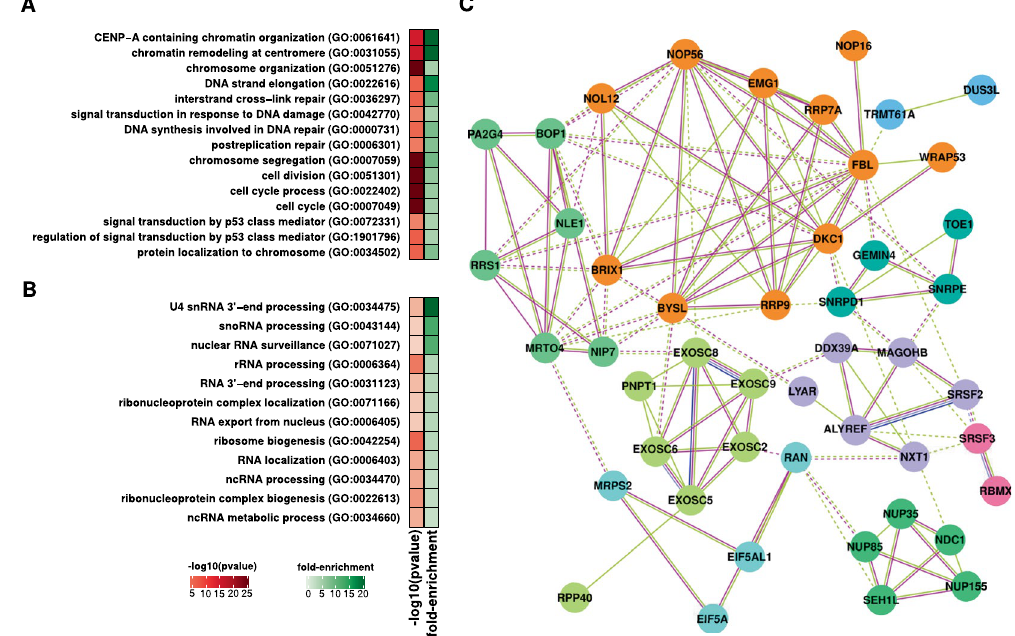
Figure 1. Characteristics of downregulated genes at 24 hours (T24) after radiation exposure in glioblastoma cell lines. ( A ) Enriched gene ontology related to cell cycle, DNA replication, and repair among downregulated genes. ( B ) RNA-related Gene Ontology (GO) terms enriched among downregulated genes summarized using REVIGO 97 . ( C ) Protein-protein interaction network, according to STRING 98 showing downregulated genes associated with RNA-related functions. Gene clusters based on the strength of connection and gene function are identified by color. Lines colors indicate the type of association: light green indicates an association based on literature findings; blue indicates gene co-occurrence; magenta indicates experimental